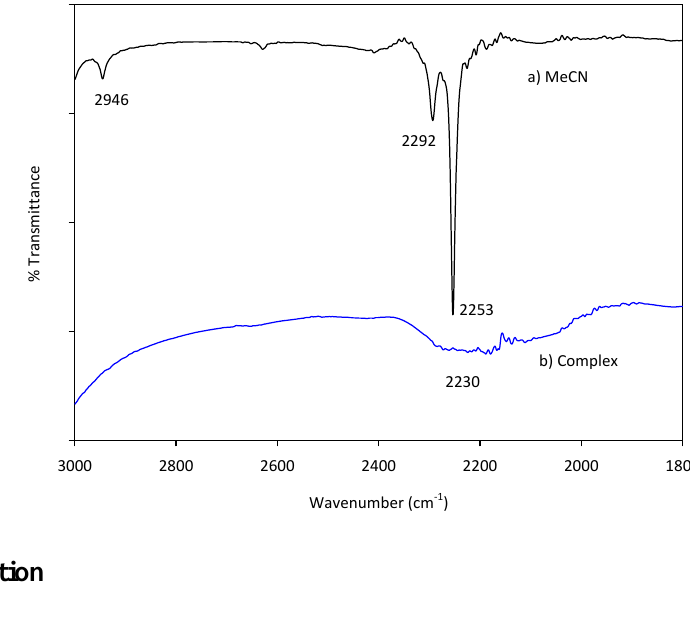
Figure 13. The IR spectra of acetonitrile and acetonitrile-Mg(II)